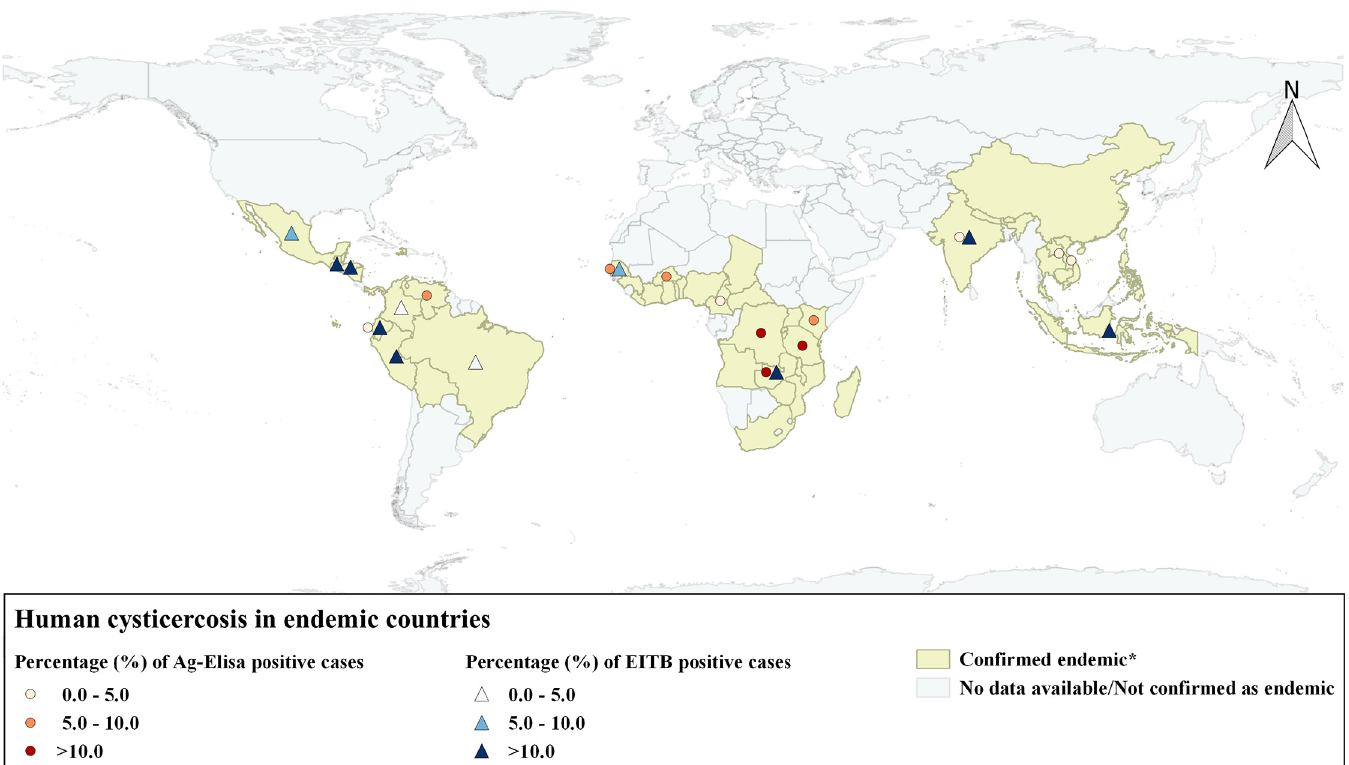
Fig 2. Global distribution of the endemic countries where Ag-ELISA and/or EITB based epidemiological studies were held. Light yellow represents the countries confirmed as endemic by the World Health Organization (WHO) until 2012 [66]. Circles represent the countries where Ag-ELISA based studies took place. Each color represents the average prevalence per country found from the selected articles in this review classified in 0 to 5 percent; 5 to 10 percent and more than 10 percent. Triangles represent the countries where EITB based studies took place. Each color represents the average prevalence per country found from the selected articles in this review classified in 0 to 5 percent; 5 to 10 percent and more than 10